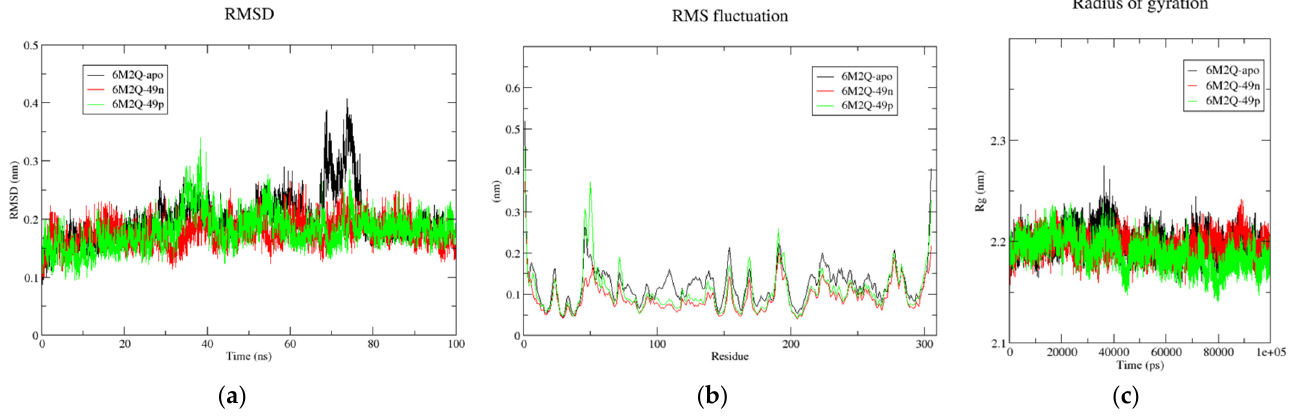
Figure 7. ( a ) Time-dependent RMSD of c- α backbone of the Mpro-apo, 6M2N-49n, and 6M2N-49p. ( b ) The RMSF for c- α atoms of Mpro-apo, 6M2N-49n, and 6M2N-49p. ( c ) Plot of Rg vs. time for Mpro-apo, 6M2N-49n, and 6M2N-49p. Table 7. The calculated average parameters for all the systems after 100 ns MD simulation run.